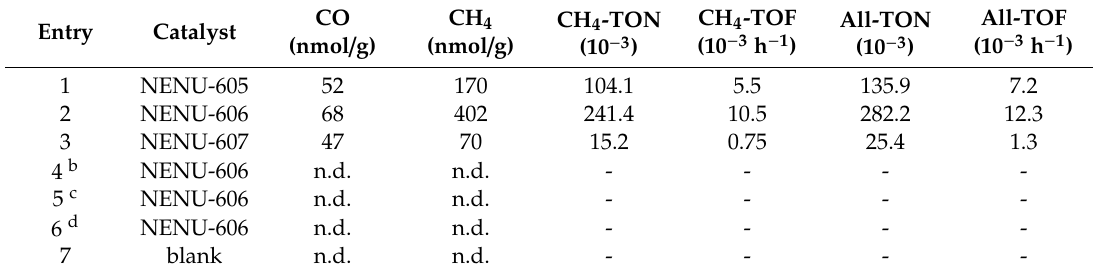
Table 4. The photocatalytic reduction of CO 2 to CH 4 using different catalysts a.